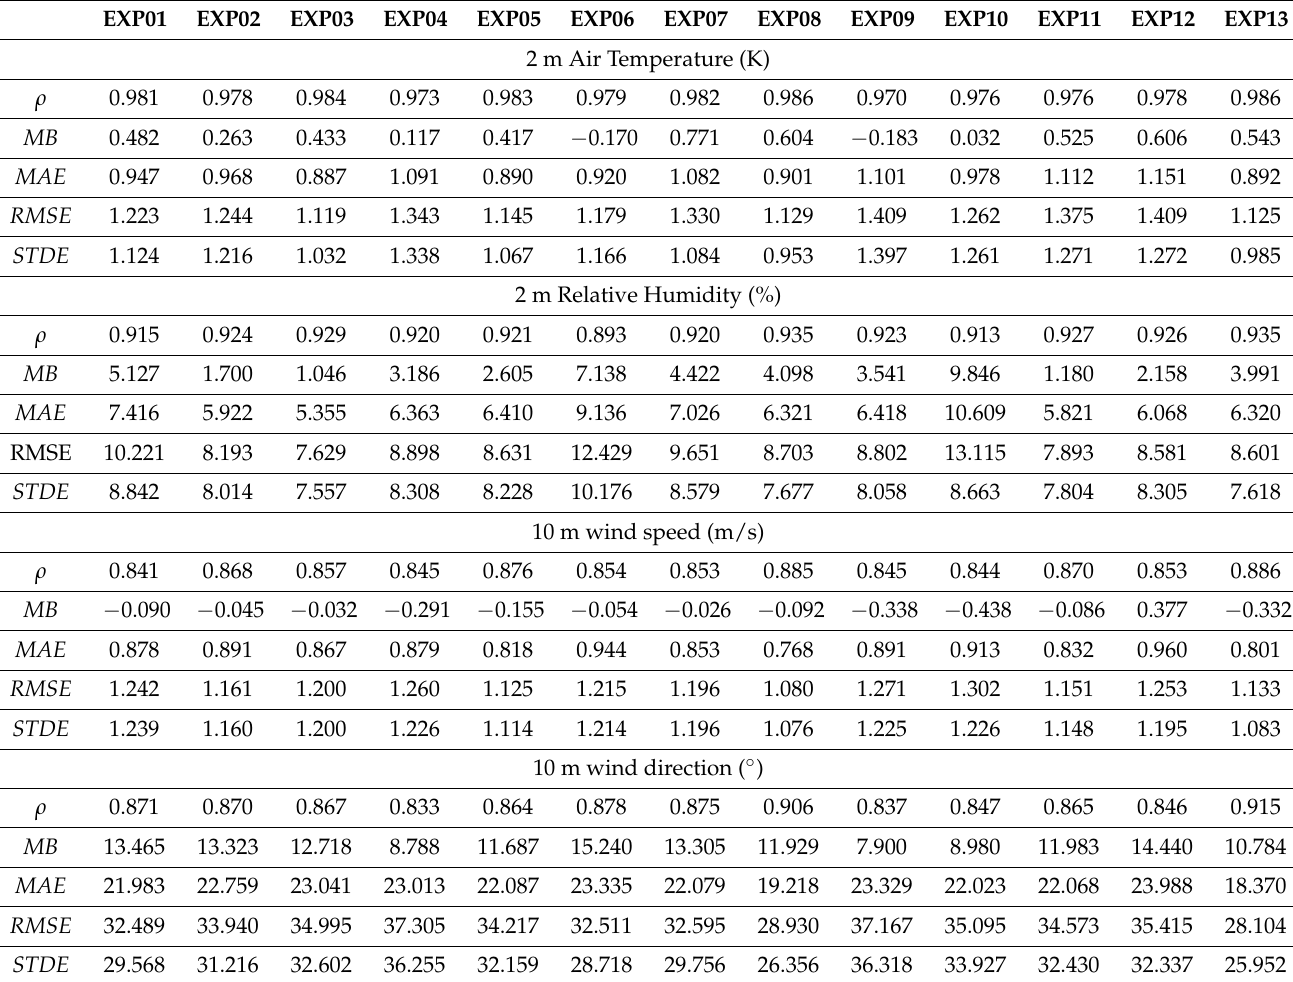
Table 7. Statistical metrics calculated for January 2019 hourly data at Aljazeera